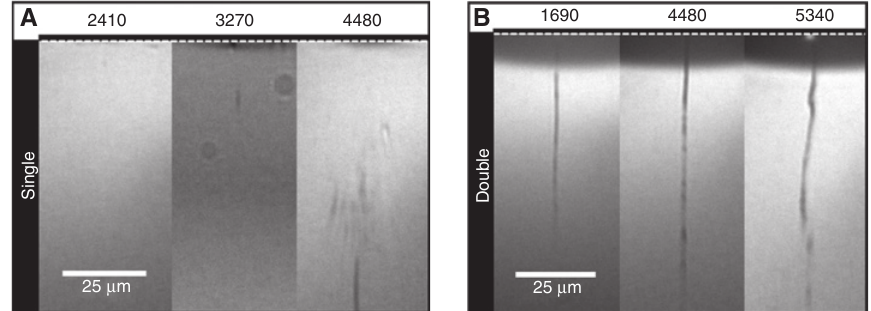
Figure 7: Time-resolved shadowgraphy images of ejection dynamics after the irradiation of a 620-nm-thick copper film with a single short laser pulse (A) or by two laser pulses (QCW + ps) (B). The fluence of the short pulse laser (mJ/cm 2 ) is written above each images, and all images have been acquired 280 ns after the ultrashort